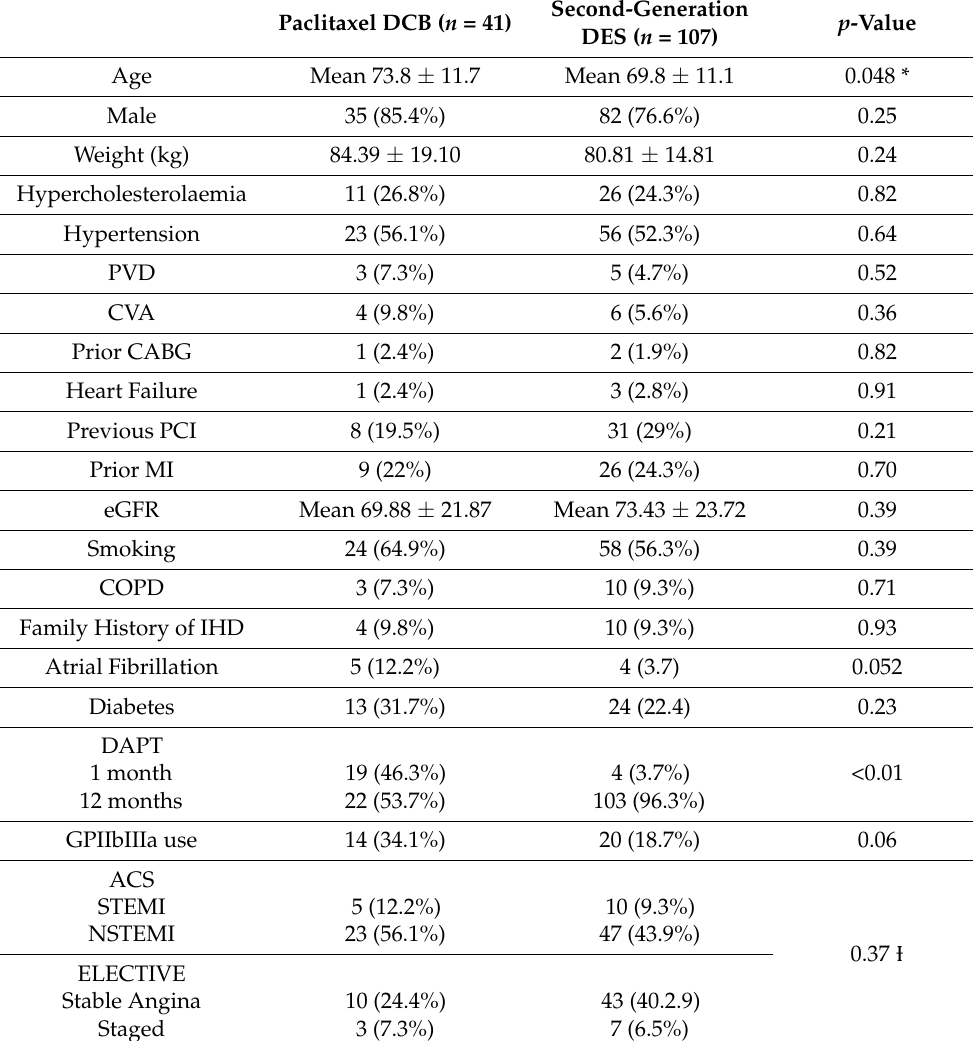
Table 1. Baseline characteristics of the patient